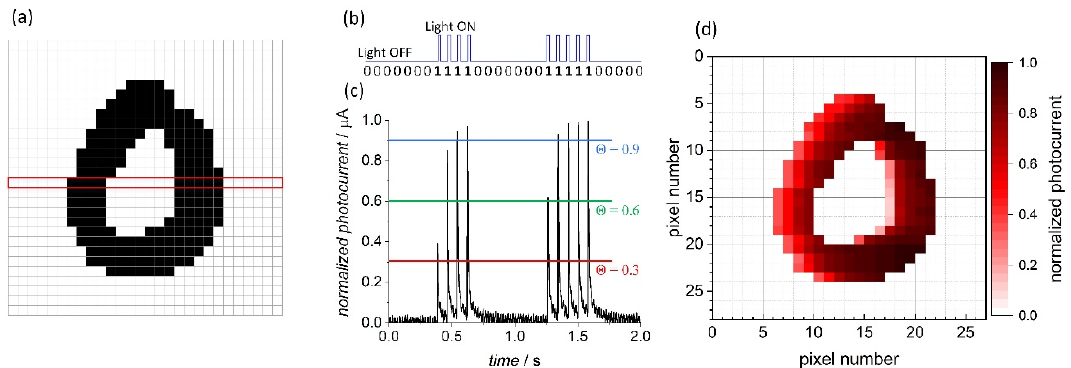
Figure 7. A 28 × 28 pixels image of a handwritten character with a marked row ( a ) translated into a sequence of bits and corresponding light pulses ( b ). A pattern of photocurrent spikes for a given binary input with three thresholds indicated ( c ). An image of the character reconstructed from the normalized photocurrent amplitudes ( d ).